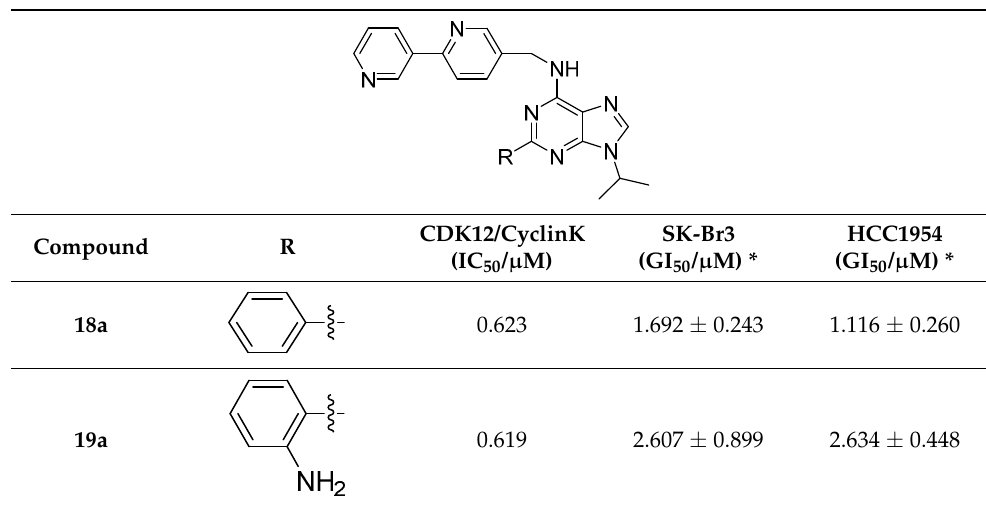
Table 2. Structure-activity relationship for aryl substituents at 2 position.